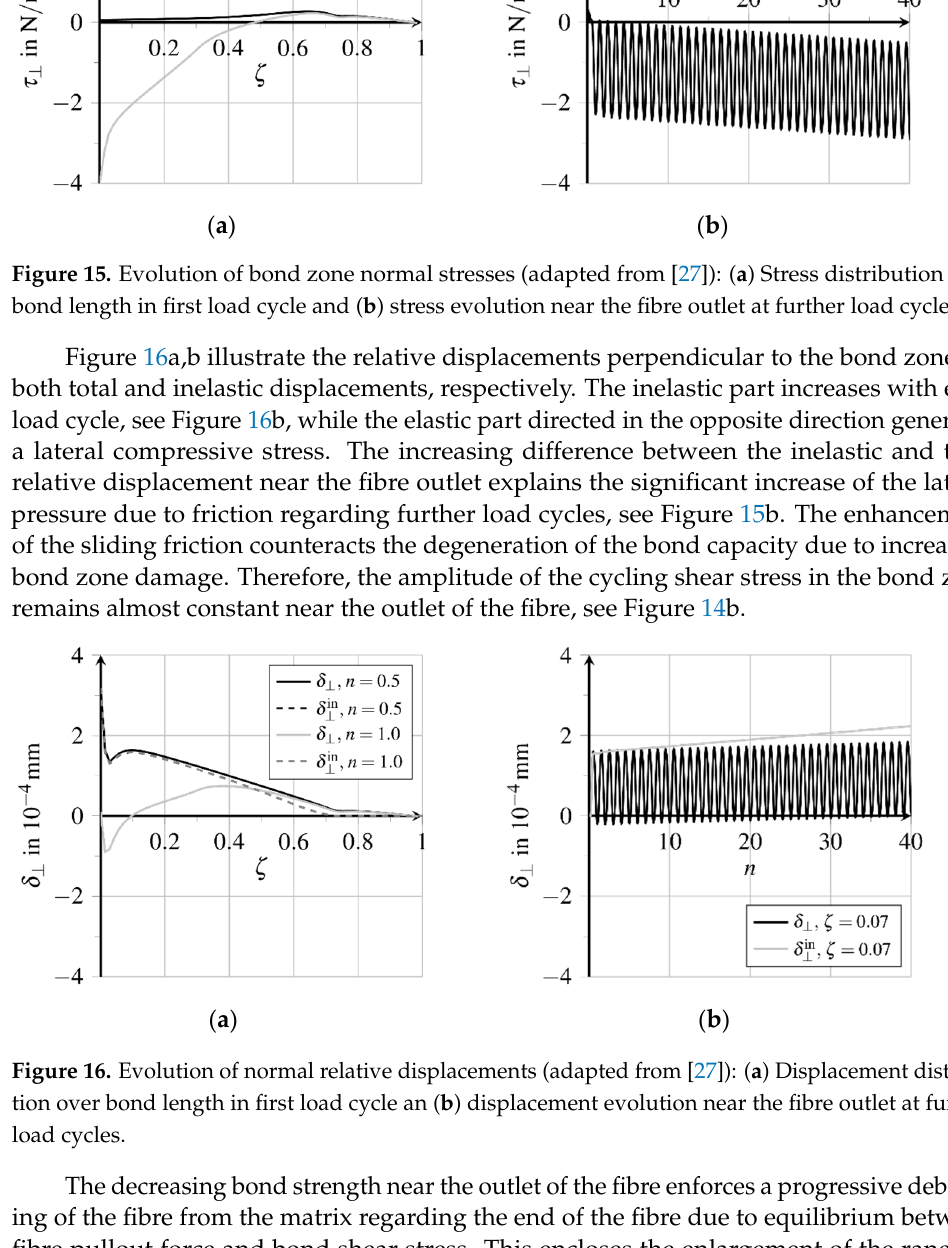
Figure 14. Evolution of bond zone shear stresses (adapted from [27]): ( a ) Stress distribution over bond length in first load cycle and ( b ) stress evolution near the fibre outlet at further load cycles.